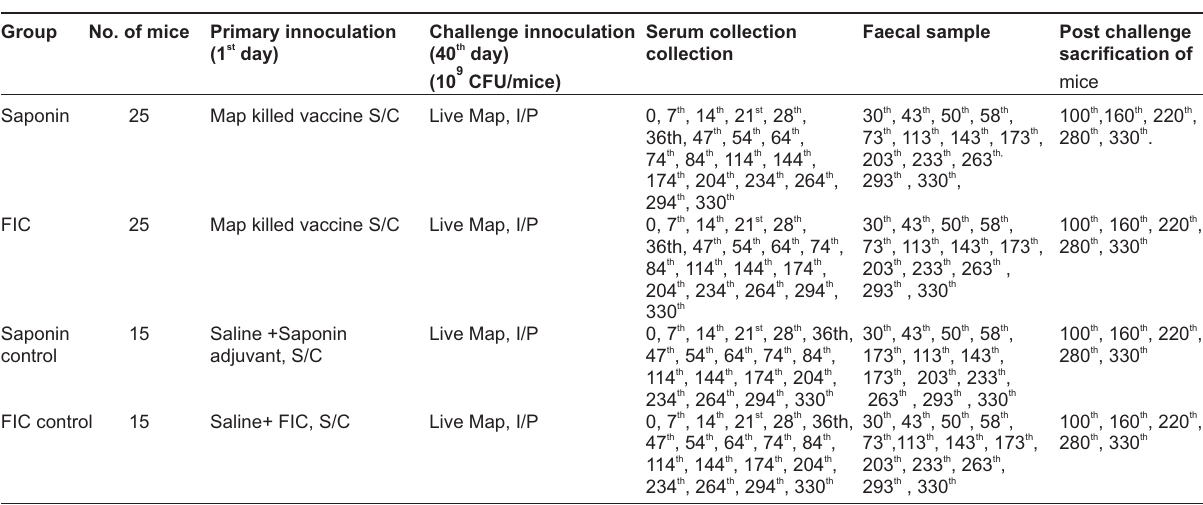
Table-1: Details of samples collected.